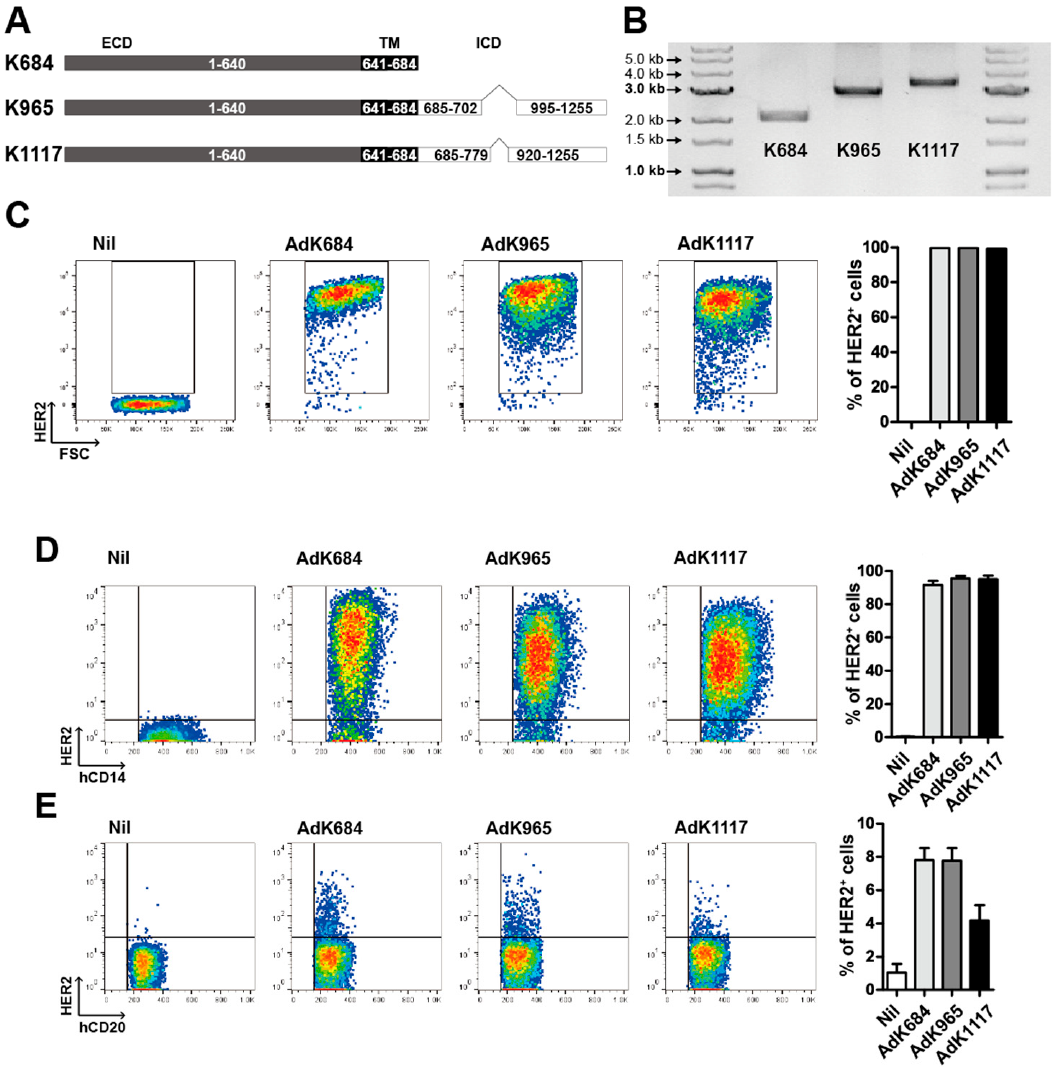
Figure 1. The development of three different engineered human epidermal growth factor receptor 2 (HER2) antigens. ( A ) Diagram of the concept of engineered HER antigens based on the extracellular domain, transmembrane domain, and intracellular domain. ( B ) The gel image of each antigen. The K684, K965, or K1117 (from left to right, respectively) construct was inserted into an adenovirus shuttle vector and digested with restriction enzymes SalI and HindIII. The expression of engineered HER2 antigens on the THP ‐ 1 ( C ) and CD14+ monocytes ( D ) and CD20+ B cells ( E ) isolated from human peripheral blood ( D ) was analyzed by flow cytometry. All data are representative of two independent experiments.